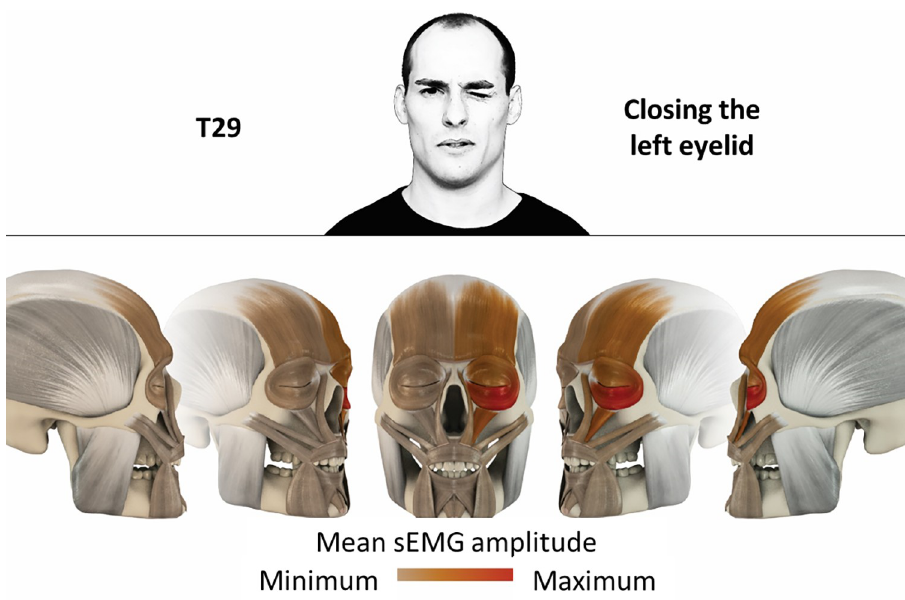
Fig 30. Color-coded facial muscle activation pattern of task T29. Closing the left eyelid. Animation by Jonas Laustro¨er.